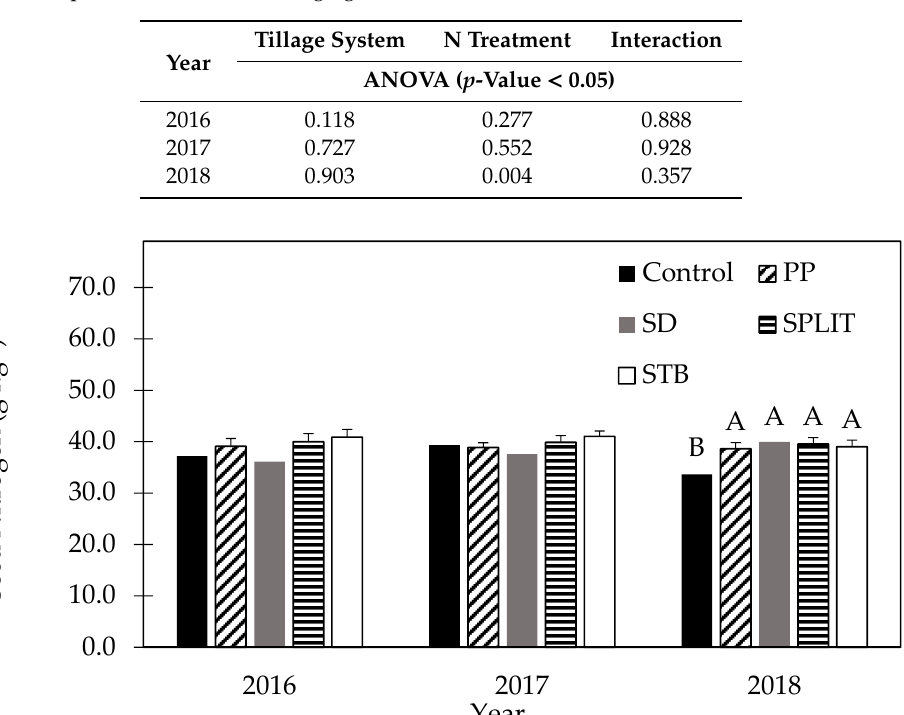
Table 4. Analysis of variance results for tillage system, nitrogen (N) treatment, and interaction effects on cotton crop seed N concentration (g kg − 1 ) in 2016, 2017, 2018.